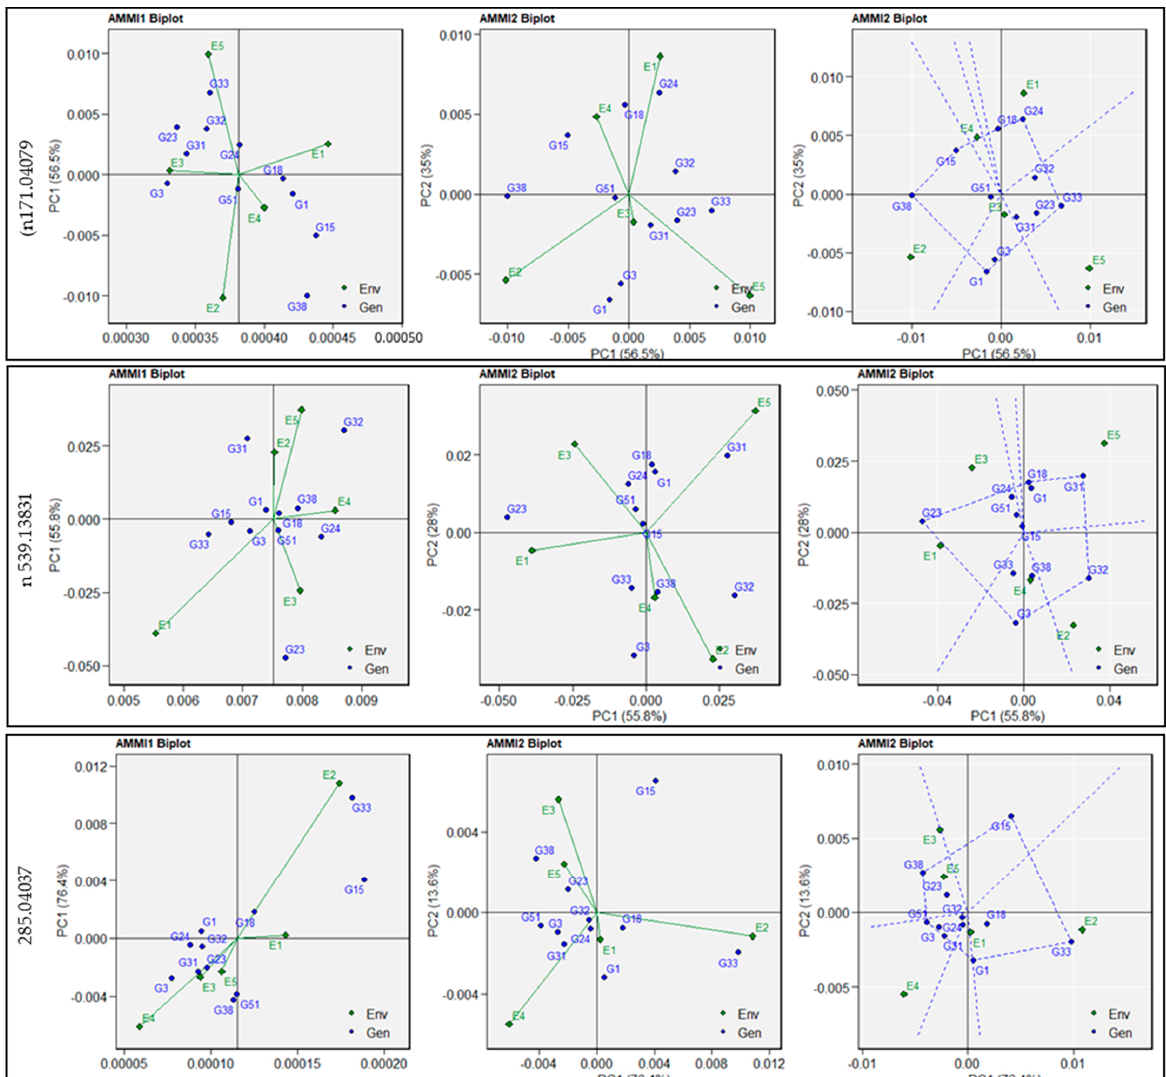
Figure 2. Additive main effects and multiplicative interaction (AMMI) for metabolites linked to antioxidant (n171.04079), starch (n539.13831), and vitamin metabolism (n285.04037) in 11 pearl millet genotypes evaluated in five environments. AMMI-based biplot generated using AMMI1 biplot (trait vs. Principal Component 1 (PC1)), AMMI2 biplot (PC1 vs. PC2), and AMMI2 biplot (PC1 vs. PC2) with the polygon